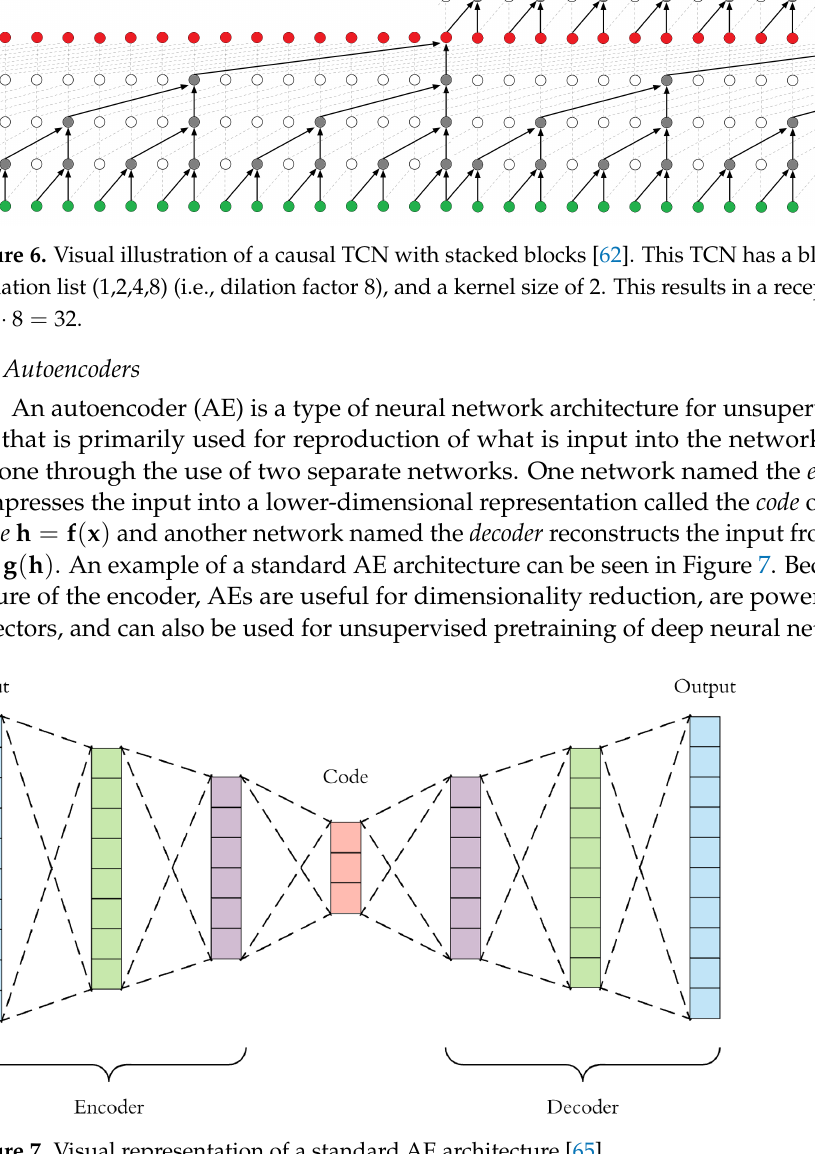
Figure 7. Visual representation of a standard AE architecture